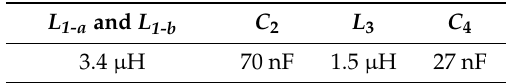
Table 2. Reactive elements of the implemented fourth-order Legendre–Papoulis